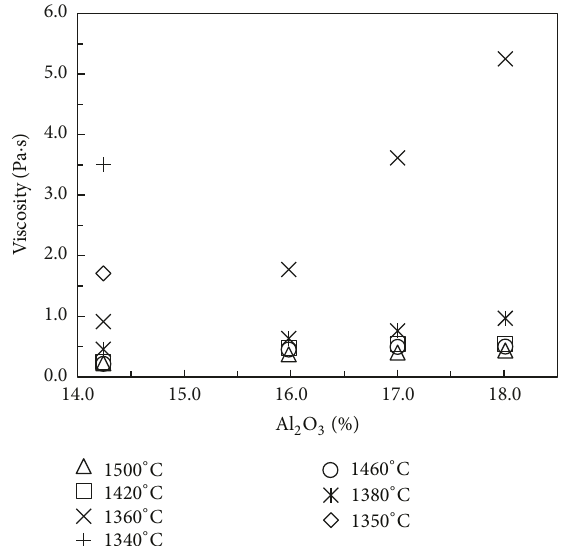
Figure 3: Viscosity isotherms for slag series A and basic slag.